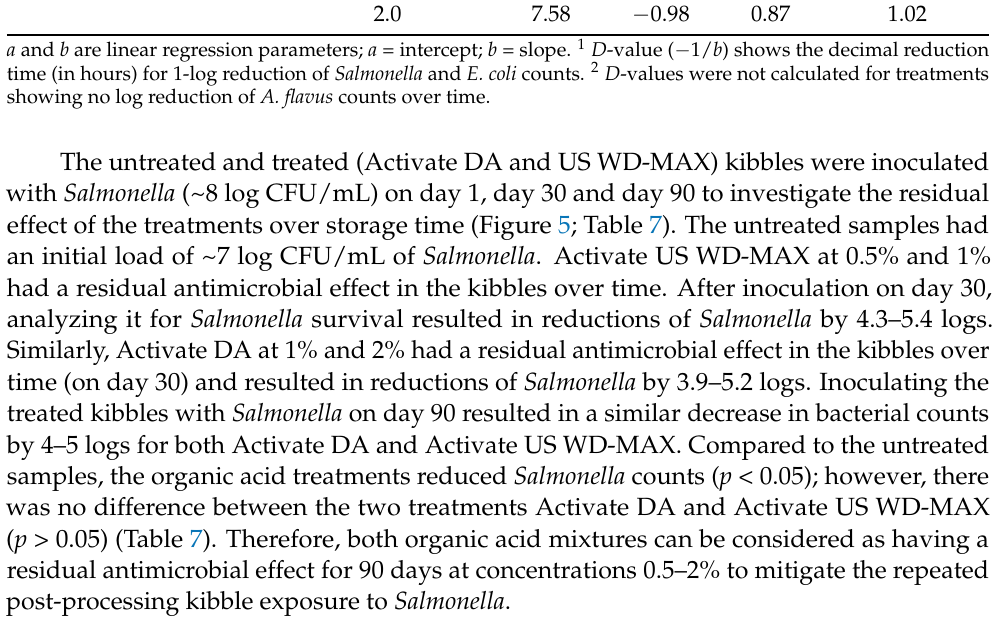
Table 7. Mean logarithmic reduction of Salmonella counts in pet food kibble treatments with inclu- sion of organic acid mixtures Activate DA at 1% and 2% and Activate US WD-MAX at 0.5% and 1% concentrations as coating, in comparison with untreated (0% organic acid), showing residual effect of treatments over 1, 30 and 90 days during storage. The logarithmic reductions were calculated as the difference between Salmonella counts in the inoculum (8 log CFU/mL) and on the kibbles (un- treated and treated). A negative control consisted of canola oil-coated kibble (no organic acid, no inoculation).